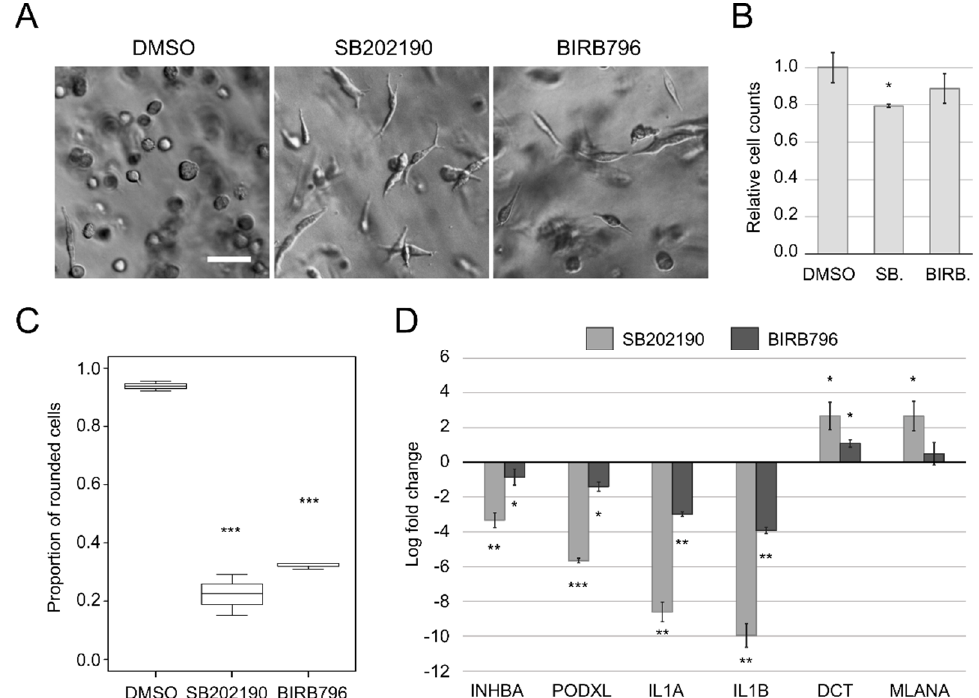
Figure 2. Phenotype switch induced by SB202190 and BIRB796 in A375M2 cultured in 3D collagen. ( A ) Representative wide-field images of cells in 3D collagen treated with DMSO, SB202190 or BIRB796. Scale bar: 75 µm. ( B ) Numbers of live cells after 48 h of the indicated treatments counted in equal volumes of 3D gels and normalised to DMSO controls (SB—SB202190, BIRB—BIRB796). Averages of three independent biological replicates; error bars: standard deviation. ( C ) Quantification of cell morphology in 3D collagen (three biological replicates, logistic regression with Wald test). ( D ) RT-qPCR detection of changes in expression of the indicated genes. Averages of three independent biological replicates; error bars: standard deviation. p -values: *** p < 0.001, ** p < 0.01, * p < 0.05.